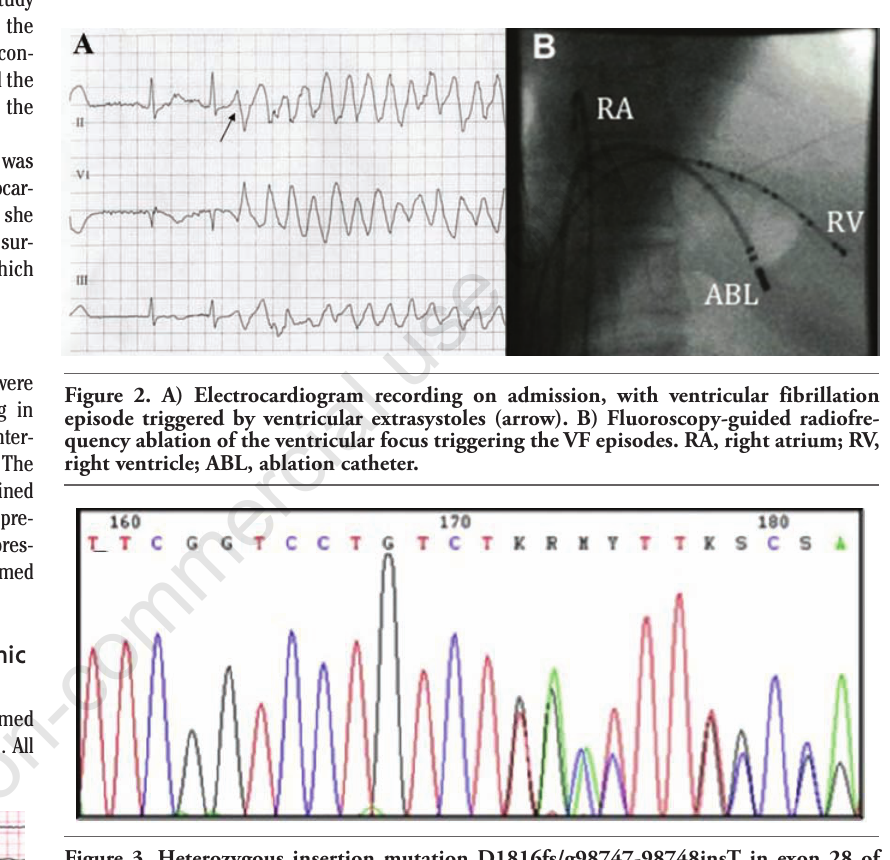
Figure 3. Heterozygous insertion mutation D1816fs/g98747-98748insT in exon 28 of SCN5A .